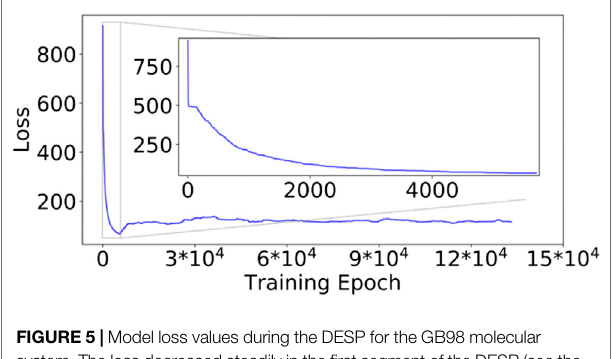
FIGURE 5 | Model loss values during the DESP for the GB98 molecular system. The loss decreased steadily in the fi rst segment of the DESP (see the inset). The model ’ s loss is slightly higher in the subsequent training of the model because the model was exposed to a more diverse molecular structure. The trajectory of the loss for the A 12 molecular system is similar in the overall structure/trend to that of the GB98 molecular system and is not shown here for brevity. DESP systematically modi fi es the molecular system ’ s energy surface.